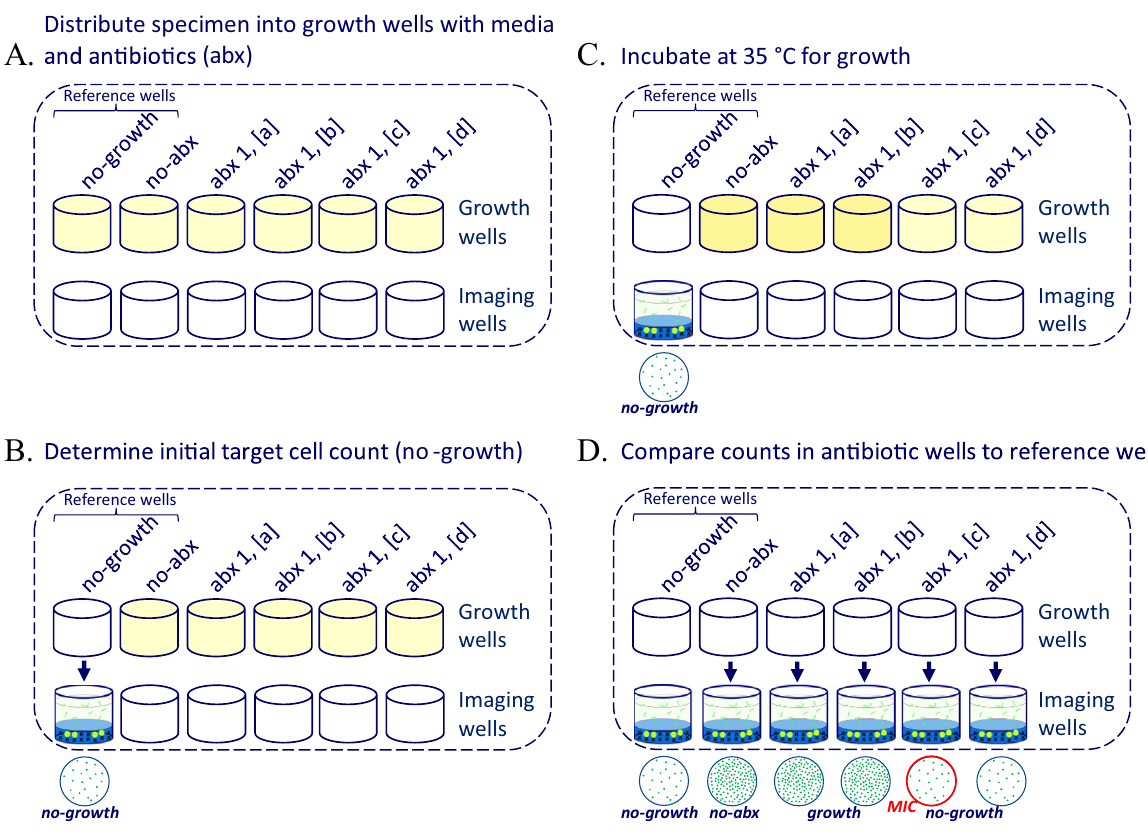
Figure 3. Principle of MultiPath AST assays. ( A ) A processed urine specimen is distributed to wells containing dried growth media and antibiotics, except for the no-growth and no-abx reference wells which do not have antibiotics. One antibiotic is shown (abx 1) at 4 increasing concentrations from [a] to [d]. ( B ) The no-growth reference sample is moved to its imaging well to quantify input cells, as shown in Fig. 2, prior to incubation. ( C ) Bacterial growth occurs at 35 °C for a predetermined amount of time, typically 4 h for rapidly dividing bacteria. ( D ) Post-incubation samples are moved to imaging wells to quantify cells. Cell counts are compared to the no-growth or no-abx reference wells to determine whether growth occurred. The MIC in this case is shown in red at abx1 [c]. By measuring growth in multiple antibiotic concentrations near CLSI breakpoints or determining MICs, categorical susceptibility (SIR) can be easily